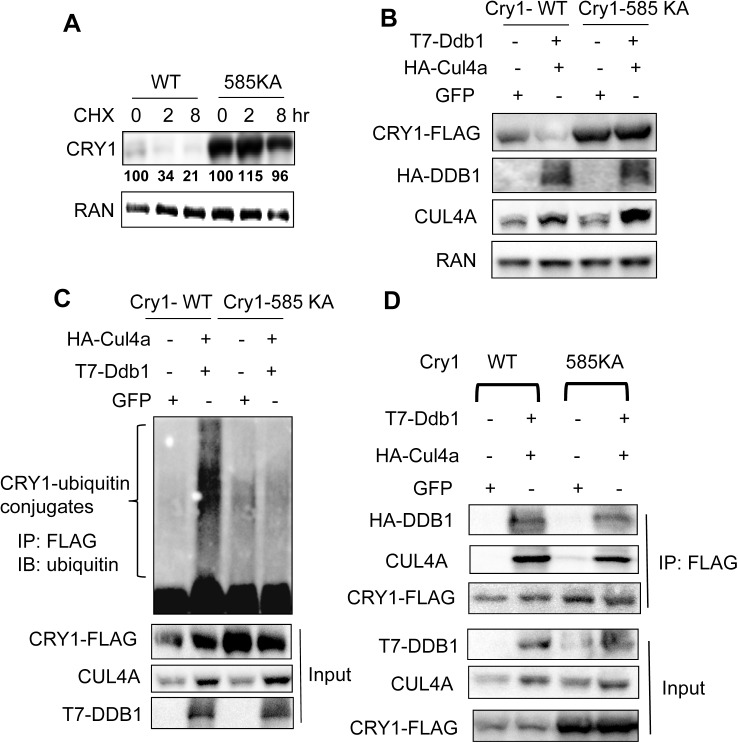
CUL4A-DDB1 E3 ligase targets the N-terminal lysine 585 of CRY1 for ubiquitination and degradation.
(A) Comparison of the CRY1-585KA-Flag vs. CRY1-WT-Flag protein stability. 48 hr later after transfection with either Cry1-WT-Flag or Cry1-585KA-Flag, 293T cells were treated with CHX for 0, 2, and 8 hr before harvest. The expression levels of FLAG-tagged CRY1 were determined by immunoblotting by anti-FLAG, quantified and normalized by loading control control RAN. The percentage of the remaining CRY1 at each time point was calculated by comparing to the CRY1 abundance at time 0 hr. (B) CRY1-585KA-FLAG mutant is resistant to degradation triggered by DDB1-CUL4A E3 ligase. After transfection with Cry1-WT-Flag vs. Cry1-585KA-Flag along with GFP control or T7-Ddb1 plus HA-Cul4a, 293T cells were harvested 48 hr later for immunoblotting with anti-FLAG. (C) Cry1-585KA-FLAG mutant is resistant to ubiquitination mediated by DDB1-CUL4A E3 ligase. 293T cells were transfected with expression vectors encoding either Cry1-WT-Flag or Cry1-585KA-Flag in the presence of GFP control or T7-Ddb1 plus HA-Cul4a. Cells were then treated with MG132 for 16 hr and harvested for ubiquitination IP. The expression levels of CRY1-FLAG, DDB1 and CUL4A in the whole cell lysates were determined by immunoblotting. (D) CRY1-585KA mutant interacts with the CUL4A-DDB1 complex. 293T cells were co-transfected with Cry1-585KA-Flag vs. Cry1-WT-Flag in the presence or absence of HA-Cul4a plus T7-Ddb1. 24 hr post-transfection, cells were treated with MG132 for 16 hr and collected for co-IP with anti-FLAG. The presence of CRY1, CUL4A, and DDB1 in the immunocomplex was detected by antibodies against CUL4A, DDB1, and FLAG.